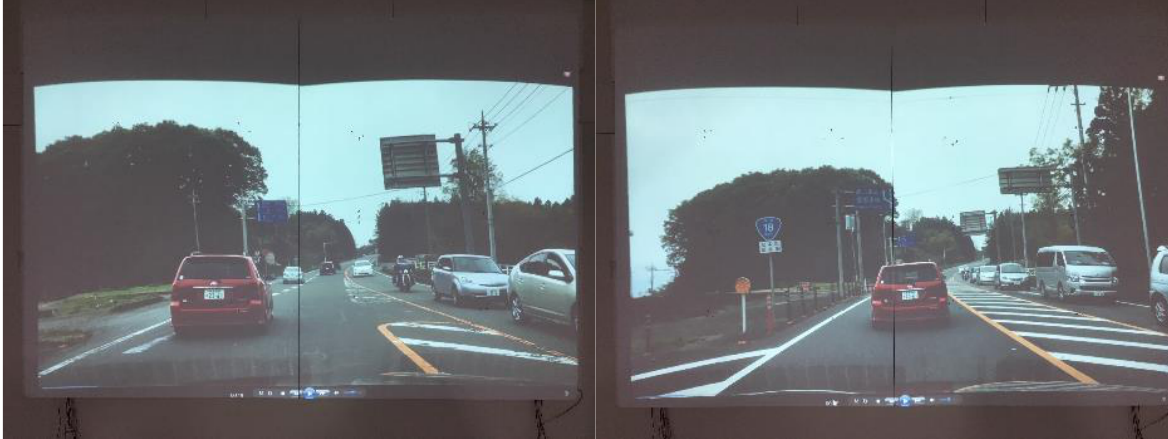
Figure 16: Scene images from a projected movie on the